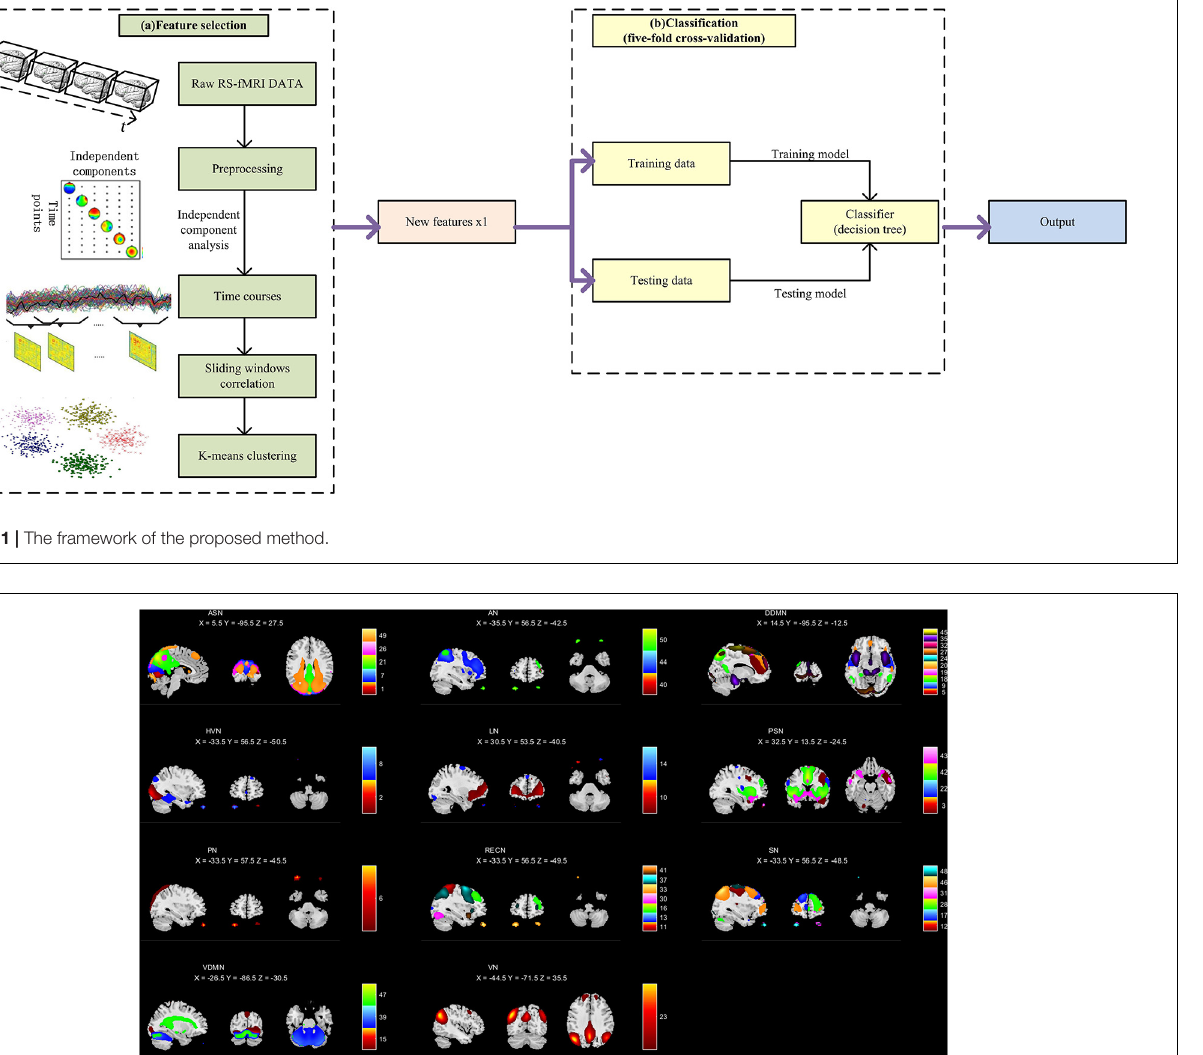
thickness = 4 mm, image dimension = 64 × 64 × 36, and voxel size = 3.4 mm × 3.4 mm × 4